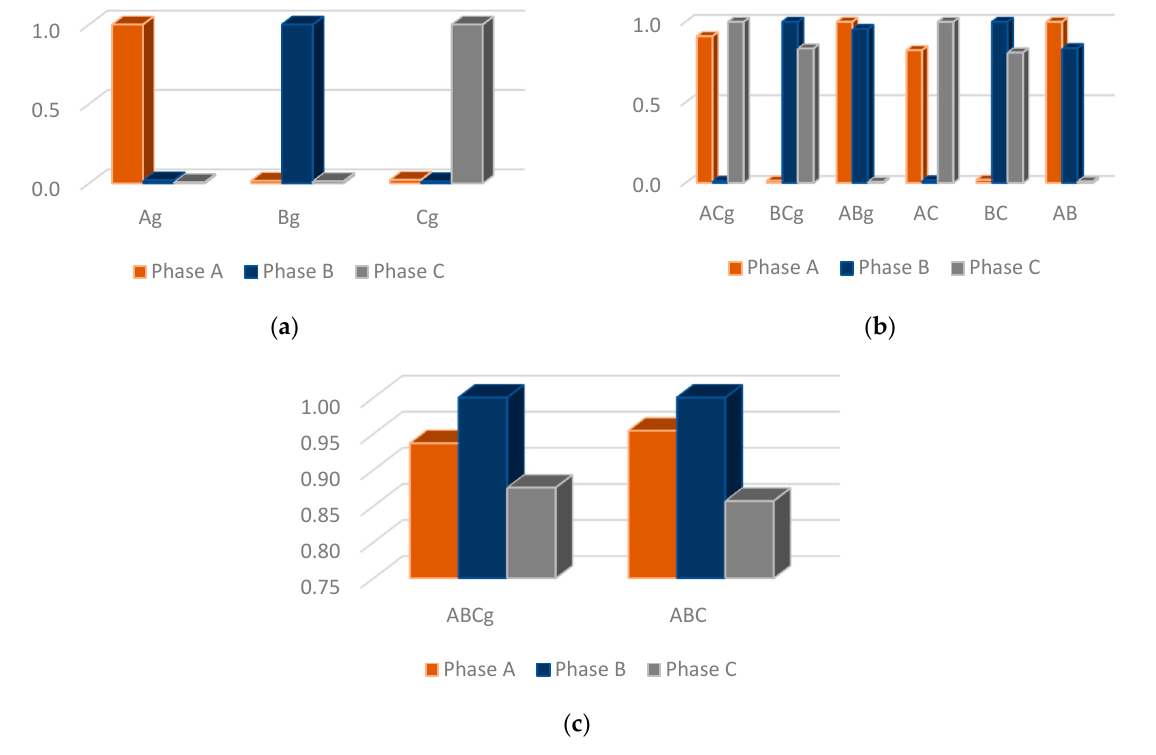
Figure 4. Illustrative example with the normalized energies. Short-Circuits: ( a ) single-phase; ( b ) two-phase; and ( c ) three-phase.